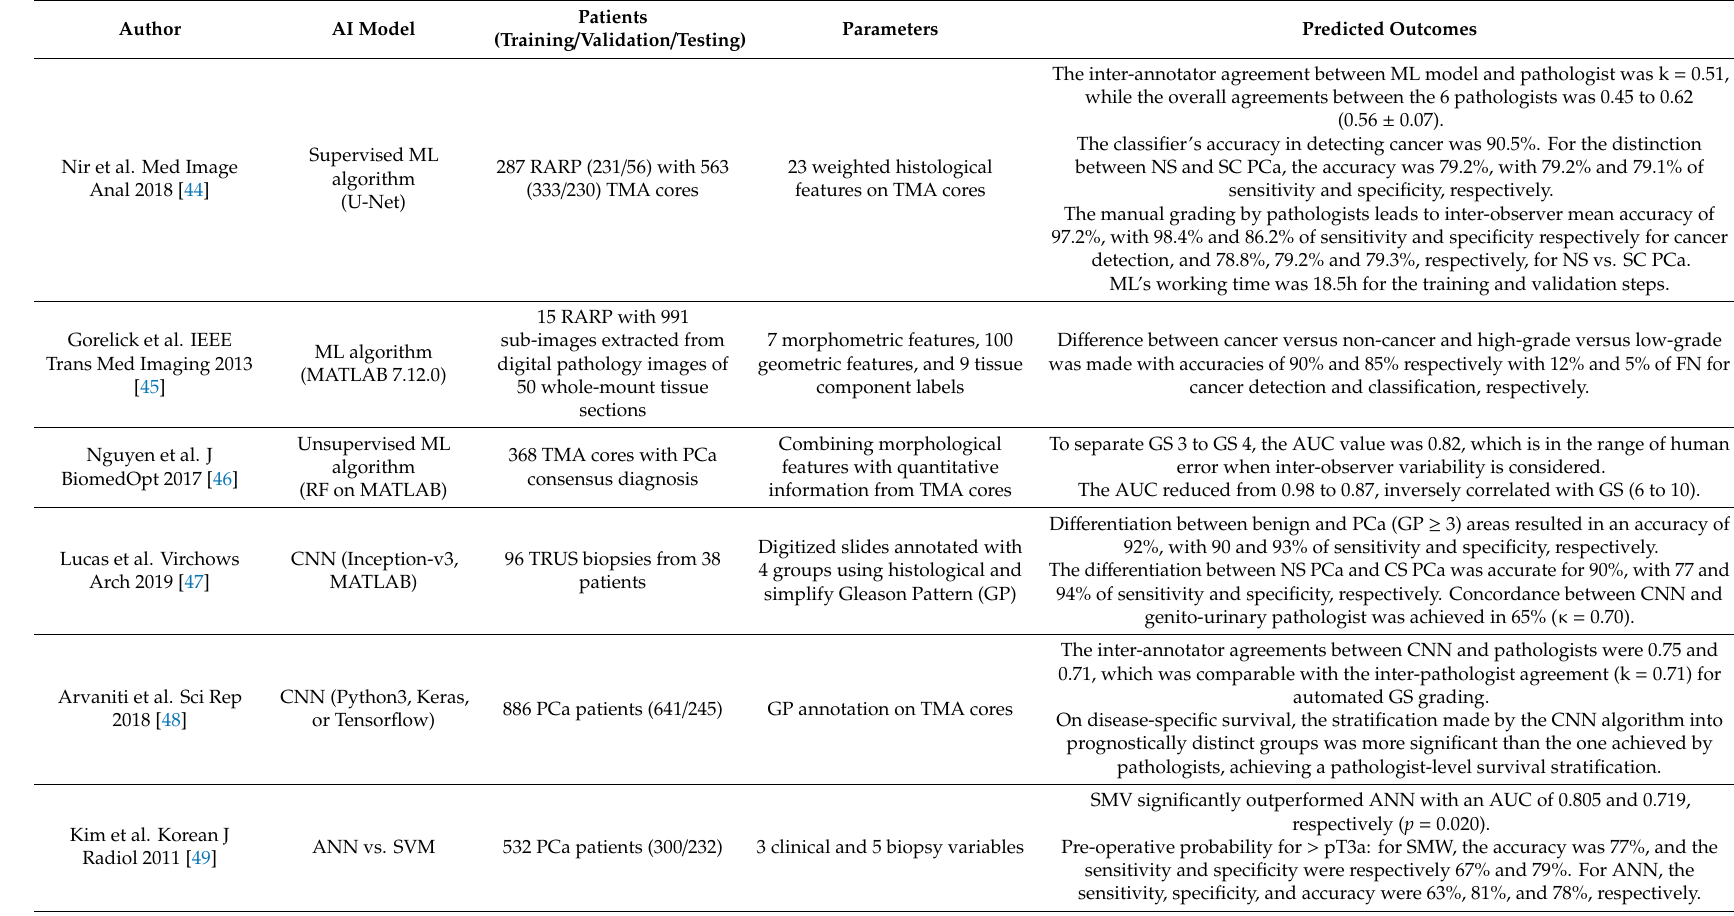
Table 2. Summary of the characteristics of studies reporting on Artificial Intelligence (AI) for prostate cancer pathological